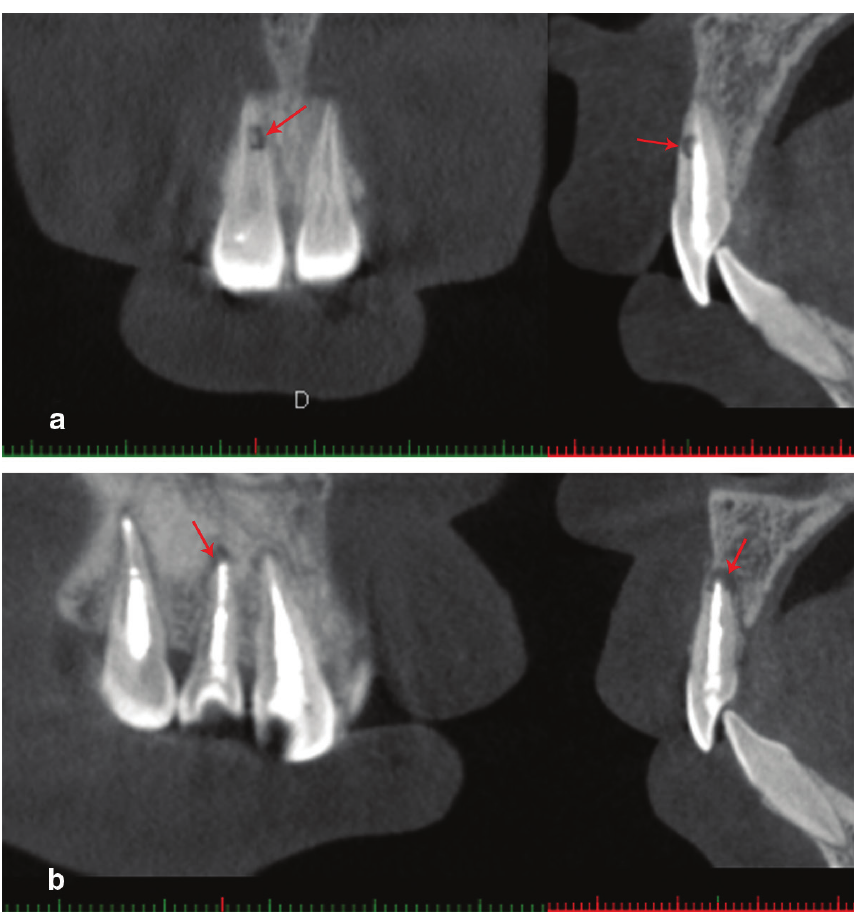
an IRR lesion image in the apex of the root of the affected tooth 12.